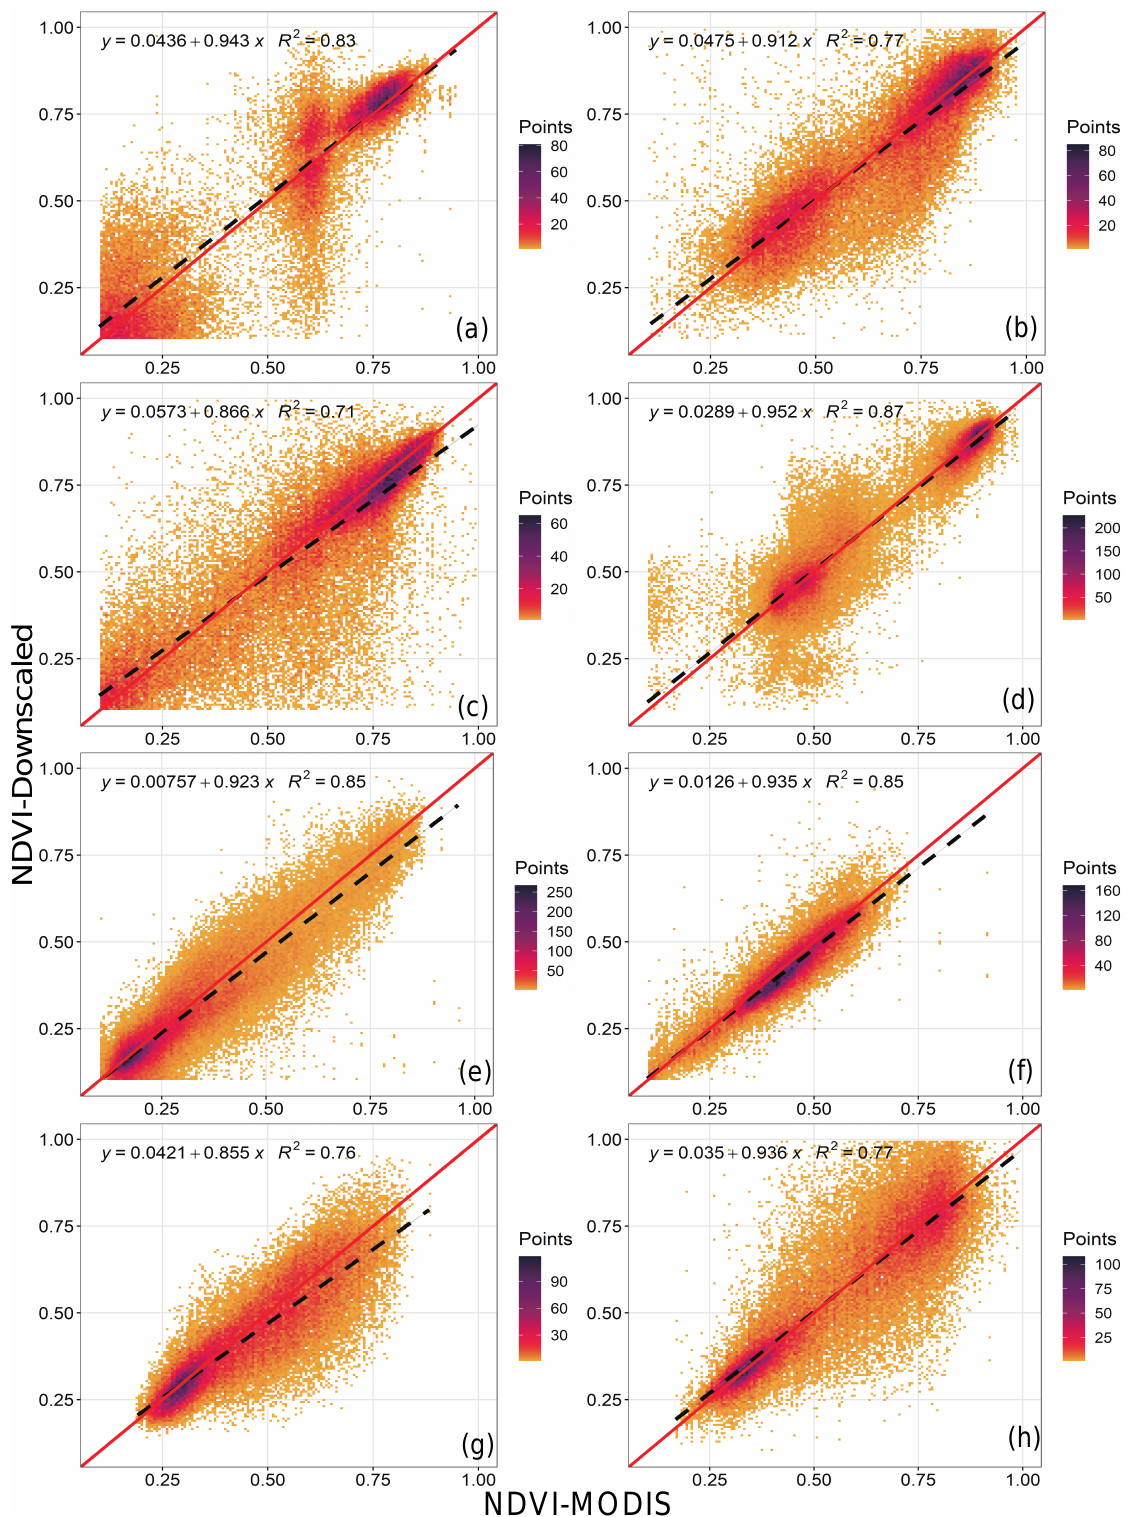
Figure 8. The correlation verification between the downscaled and MODIS NDVI for different vegetation types. The vegetation types ( a – h ) are the same as those in Figure